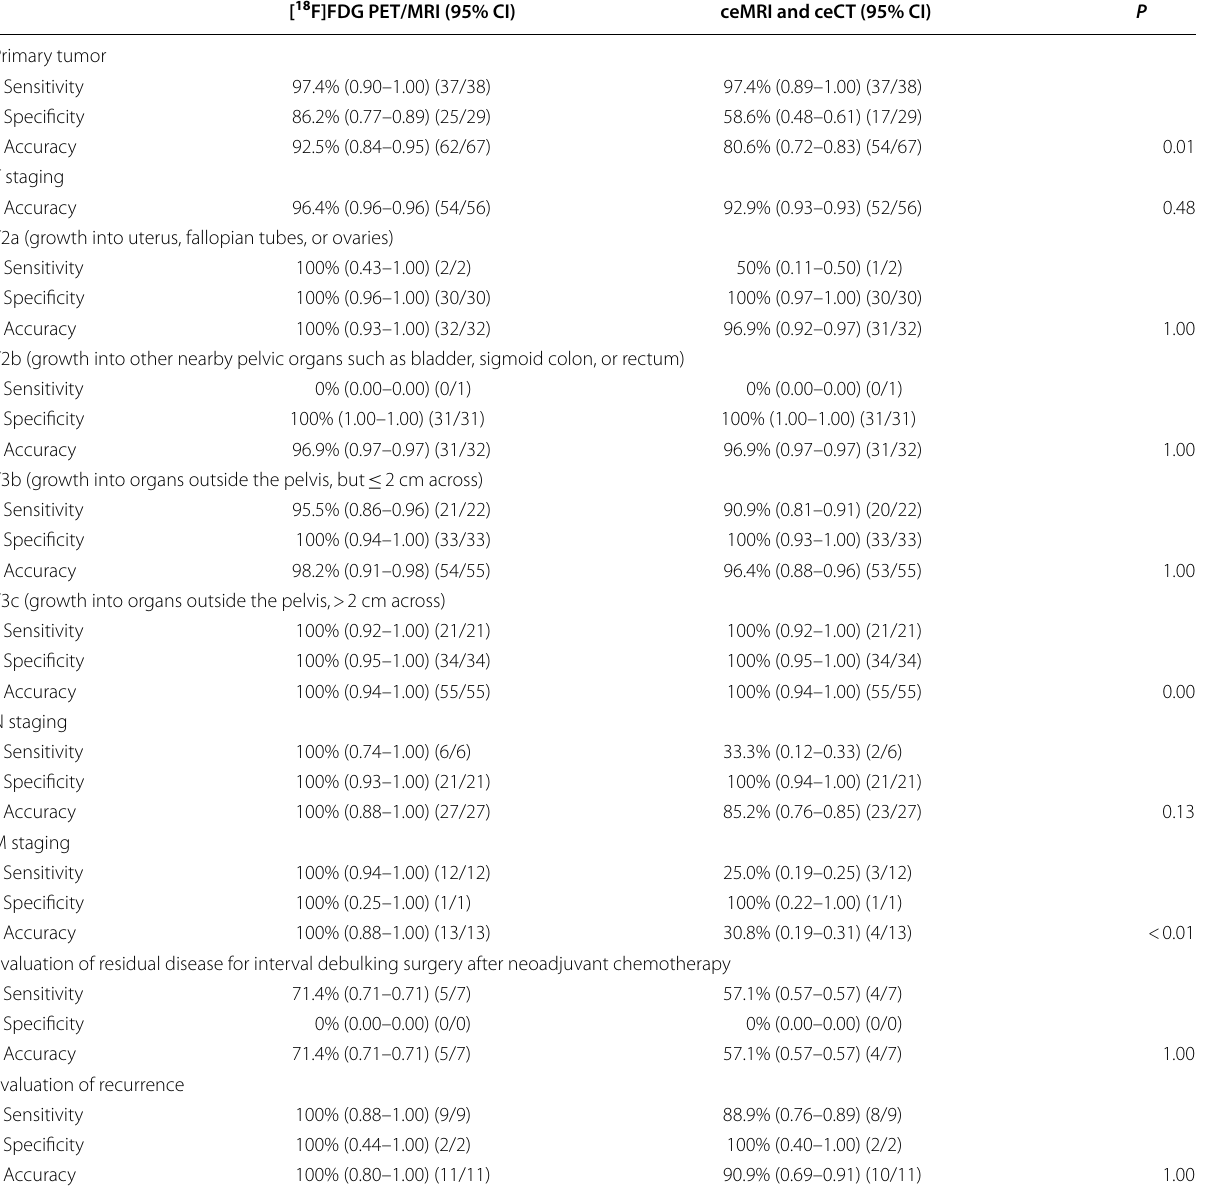
Table 5 Comparison of [ 18 F]FDG PET/MRI with ceMRI and/or ceCT for patient-based T, N and M staging, detection of residual disease after neoadjuvant chemotherapy and detection of recurrence [ 18 F]FDG PET/MRI (95%